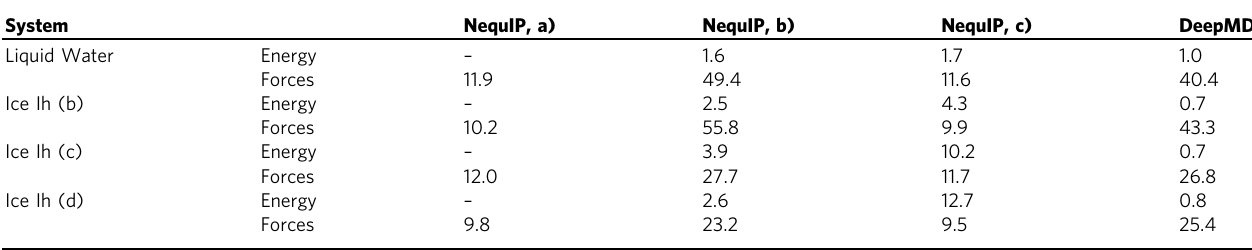
Table 3 RMSE of energies and forces on liquid water and the three ices in units of [meV/molecule] and [meV/ Å ], with energy errors normalized by the number of molecules in the